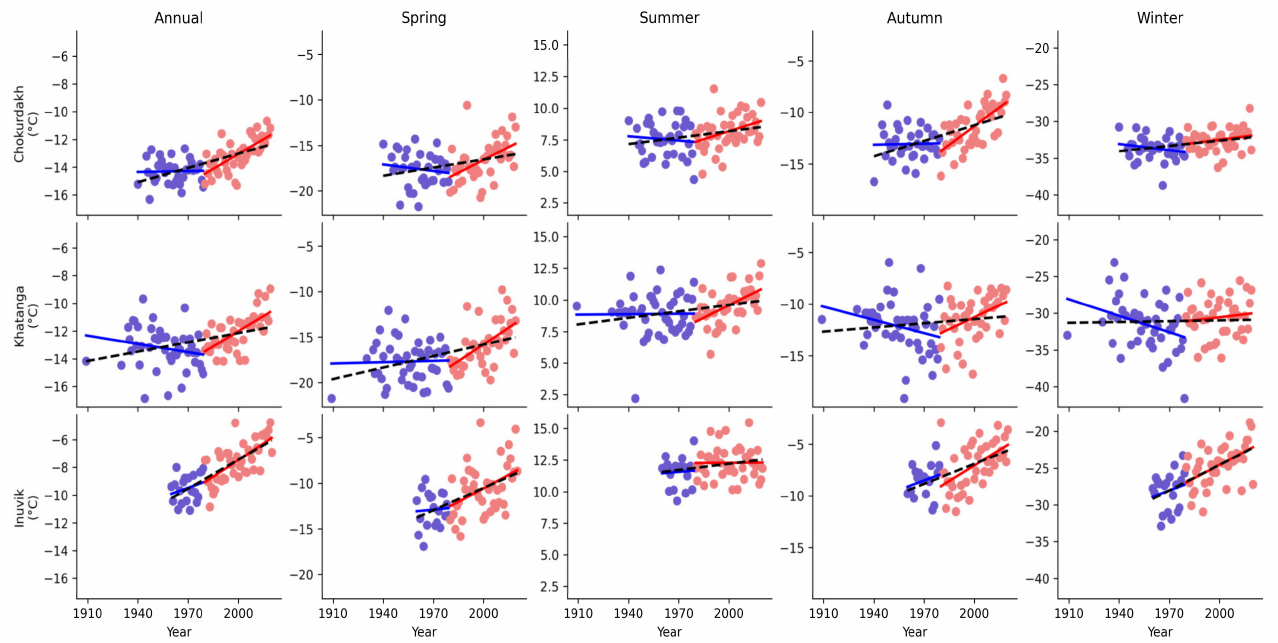
Figure 1. Annual, spring, summer, autumn and winter air temperature data were obtained from the local meteo.ru database for Chokurdakh (YAK) and Khatanga (TAY), while they were obtained from climate.weather.gc.ca, Accessed on 30 August 2021 for Inuvik (CAN) for annual, spring, summer, autumn and winter,